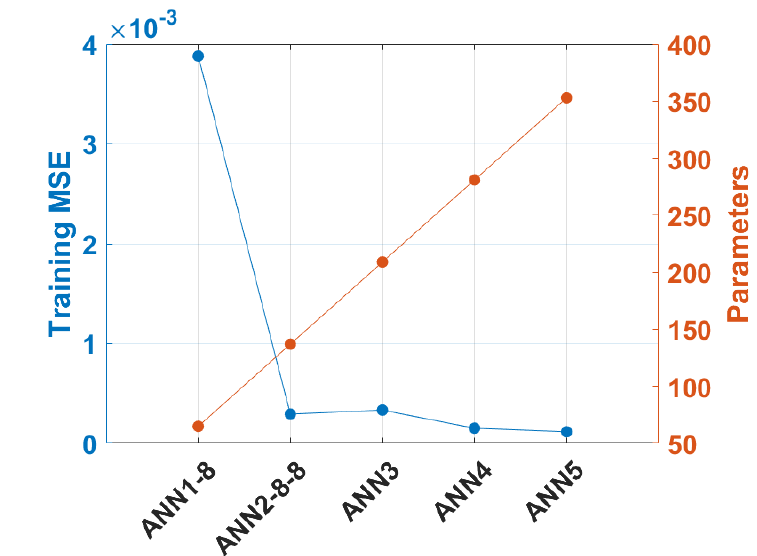
Figure 5. Training results of multi-hidden-layer ANN with 8 hidden